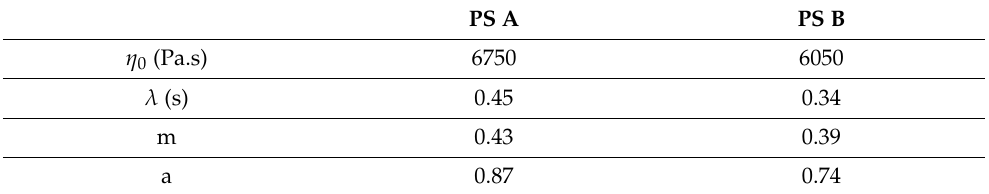
Table 1. Rhelogical parameters of the two polystyrenes (Generalized Carreau law).